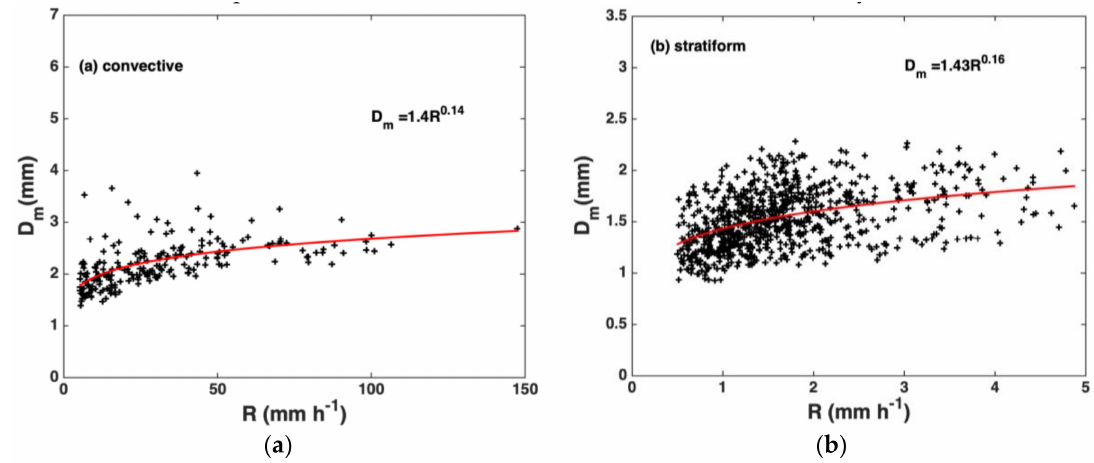
Figure 5. As in Figure 3, except for D m versus